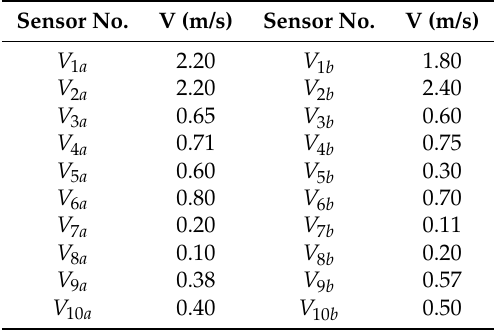
Table A3. Results of air velocity measurements, mechanical ventilation. Sensor No. V (m/s) Sensor